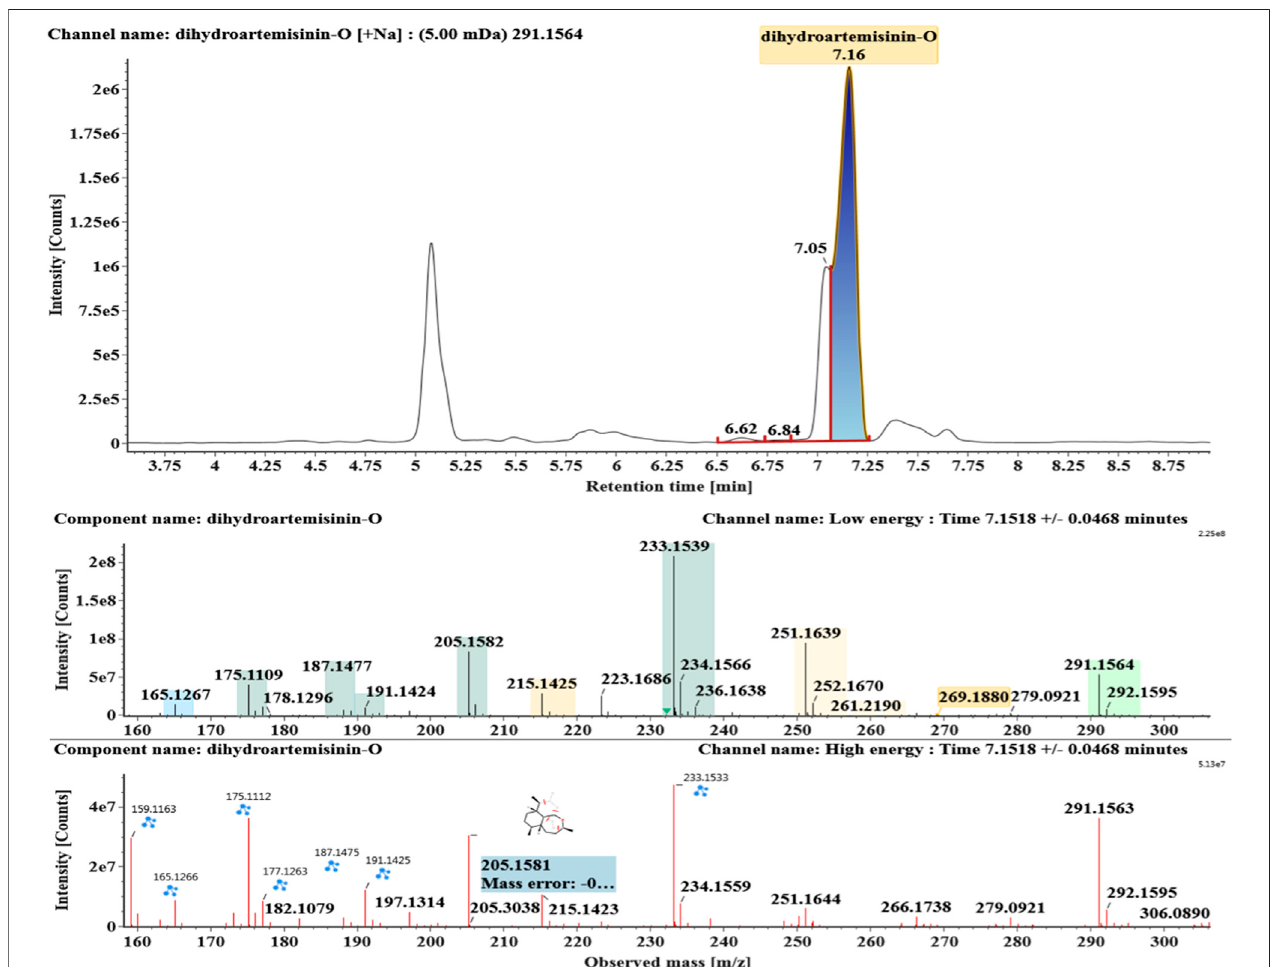
FIGURE 9 | Extracted ion chromatograms and mass spectrometry (MS E ) spectra of M8 .